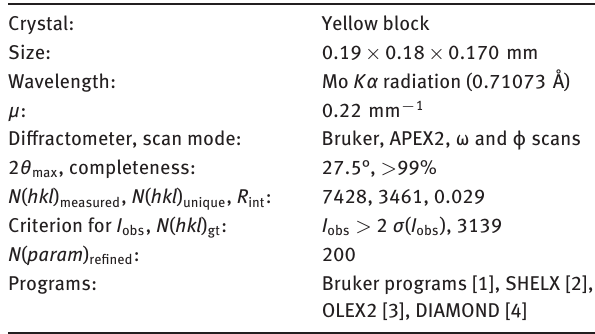
Table 2: Fractional atomic coordinates and isotropic or